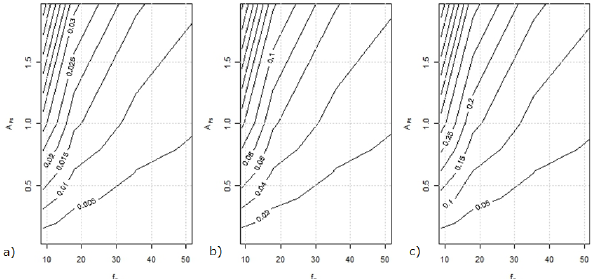
Fig. 11. (a) and (b) : 1Z resp. a of the exponential step response function, Eq. (7) in relation to M and R .